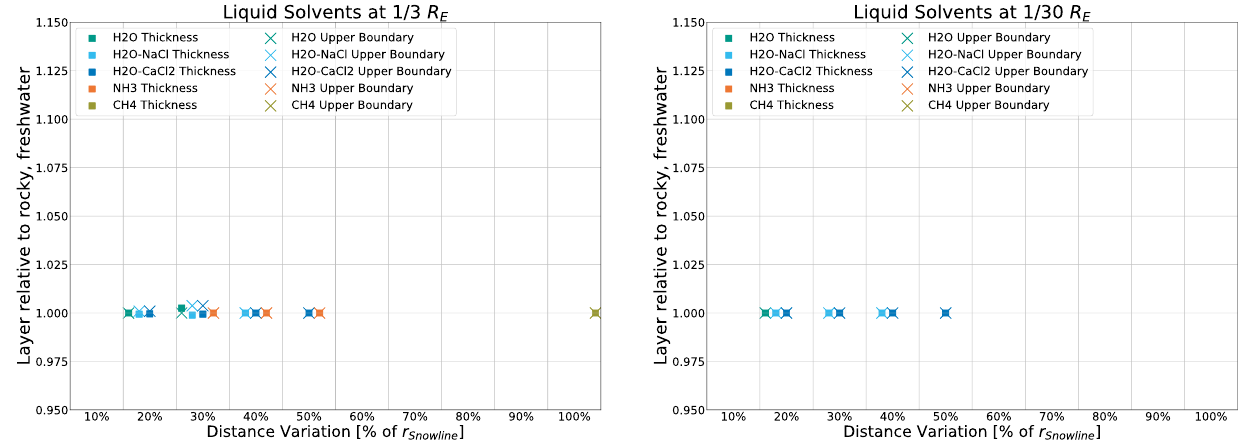
Figure A8. Deviation from the rocky, freshwater model (with input being the average spectrum of 20 AGNs) for a simulation with input coming from a single, weak source (NGC 3516).